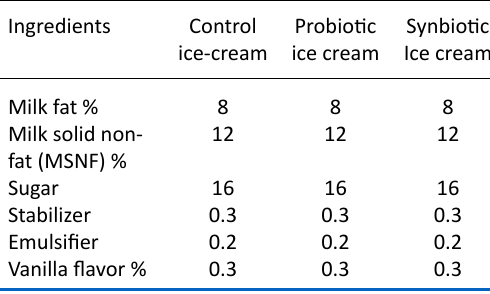
table 1. Ice cream mixtures